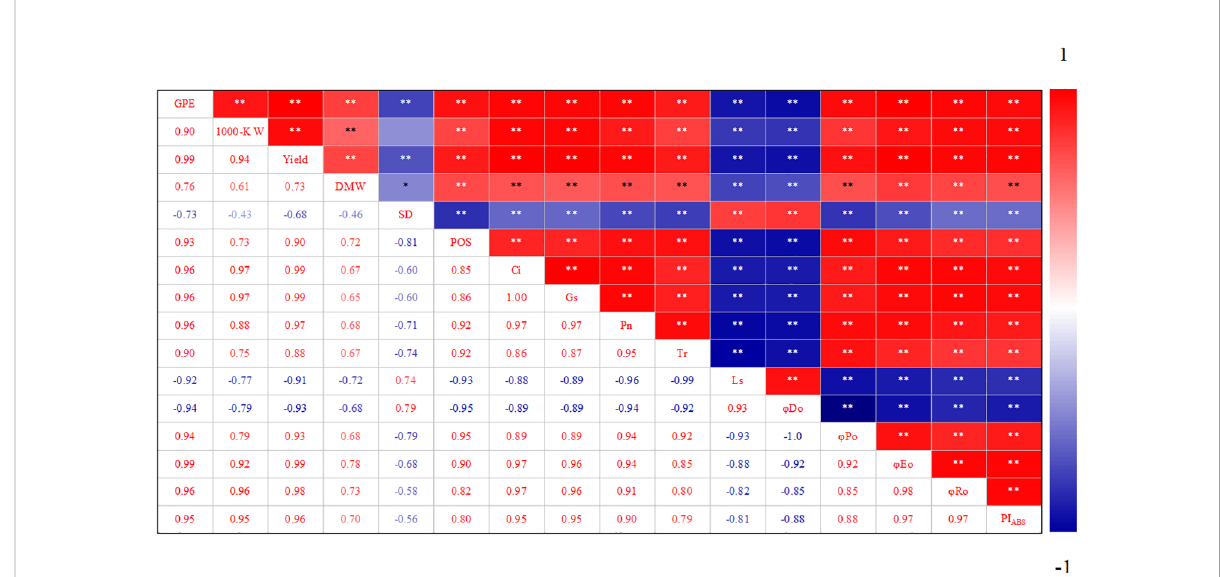
FIGURE 7 Correlation analysis of photosynthetic characteristics of soaking seeds with H 2 O 2 under waterlogging stress. GPE: Grains per ear; 1000-K W: 1000-kernel weight; DMW: Dry matter weight; SD: Stomatal density; POS: Proportion of open stomata; Ci: Intercellular CO 2 concentration; Gs: Stomatal conductance; Pn: The net photosynthetic rate; Tr: Transpiration rate; Ls: Calculate the pore limit value; j Do: Quantum yield of electron transport (at t = 0); j Po: The maximum quantum yield of primary photochemistry (at t = 0); j Eo: Quantum yield of electron transport (at t = 0); j Ro: Quantum yield for reduction of end electron acceptors at the PSI acceptor side (RE) (at t = 0); PI ABS : The performance index for energy conservation from exciton to the reduction of intersystem electron